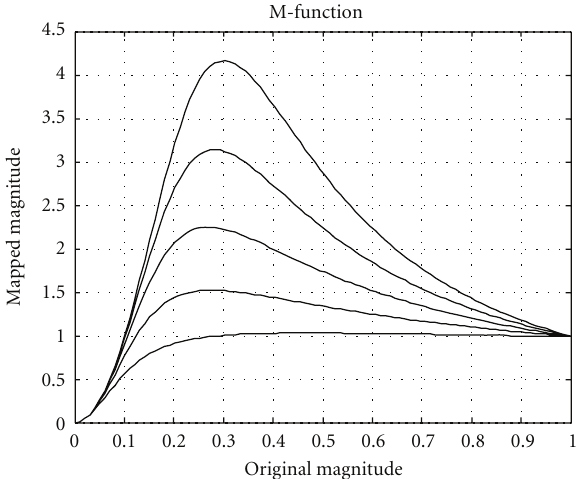
Figure 4: Examples of the M-function that maps the magnitude of the structure tensor. If the magnitude of the structure tensor is too low, the magnitude is set to zero for the control tensor, such that no highpass information is used in this part of the data. The overshoot is intended to amplify structures that have a magnitude that is slightly above the noise threshold.